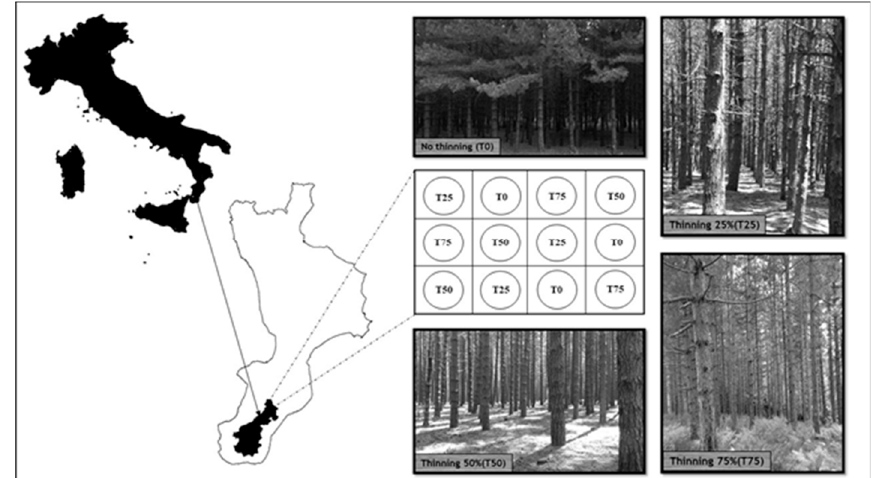
Figure 1. Location of the study area in Southern Italy (Calabrian Region) and the applied experimental design.